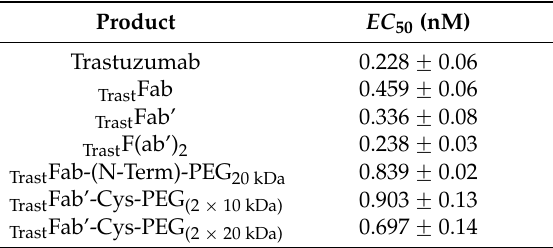
Table 2. Table of EC 50 values of Trastuzumab and derivatives binding to HER2 receptor. EC 50 values were determined by ELISA (GraphPad Prism